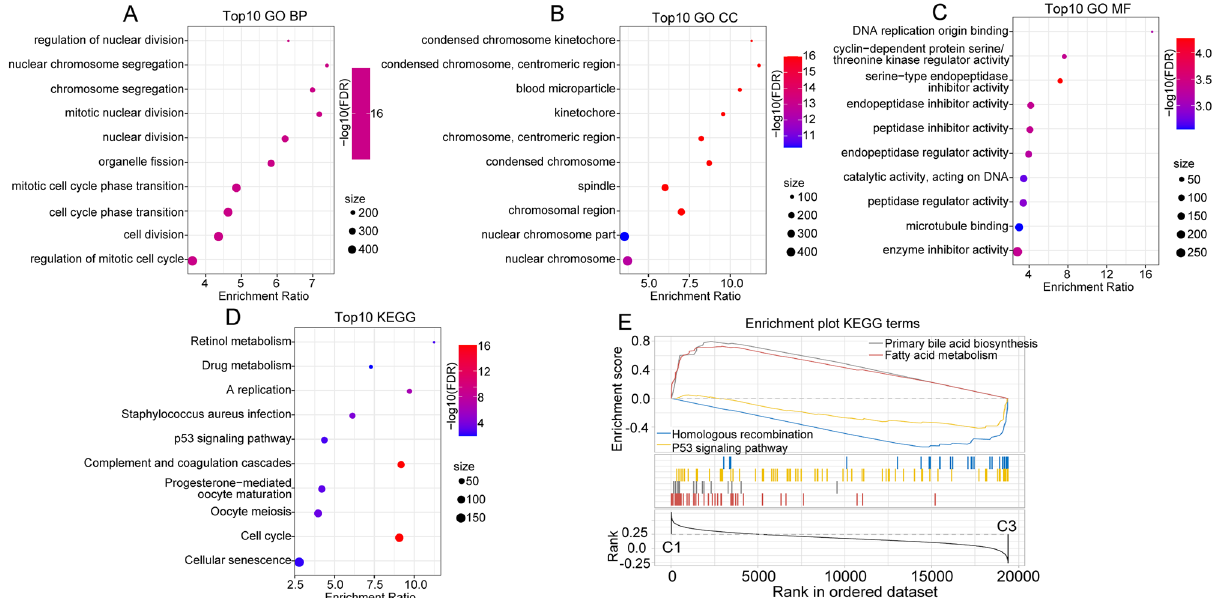
Figure 7. Functional enrichment of fatty acid-related long noncoding RNAs (lncRNAs). ( A – D ) Gene Ontology (GO) and Kyoto Encyclopedia of Genes and Genomes (KEGG) analysis of differentially expressed genes (DEGs) from the TCGA dataset. ( E ) Gene set enrichment analysis (GSEA) of the C1 and C3 subtypes (TCGA).